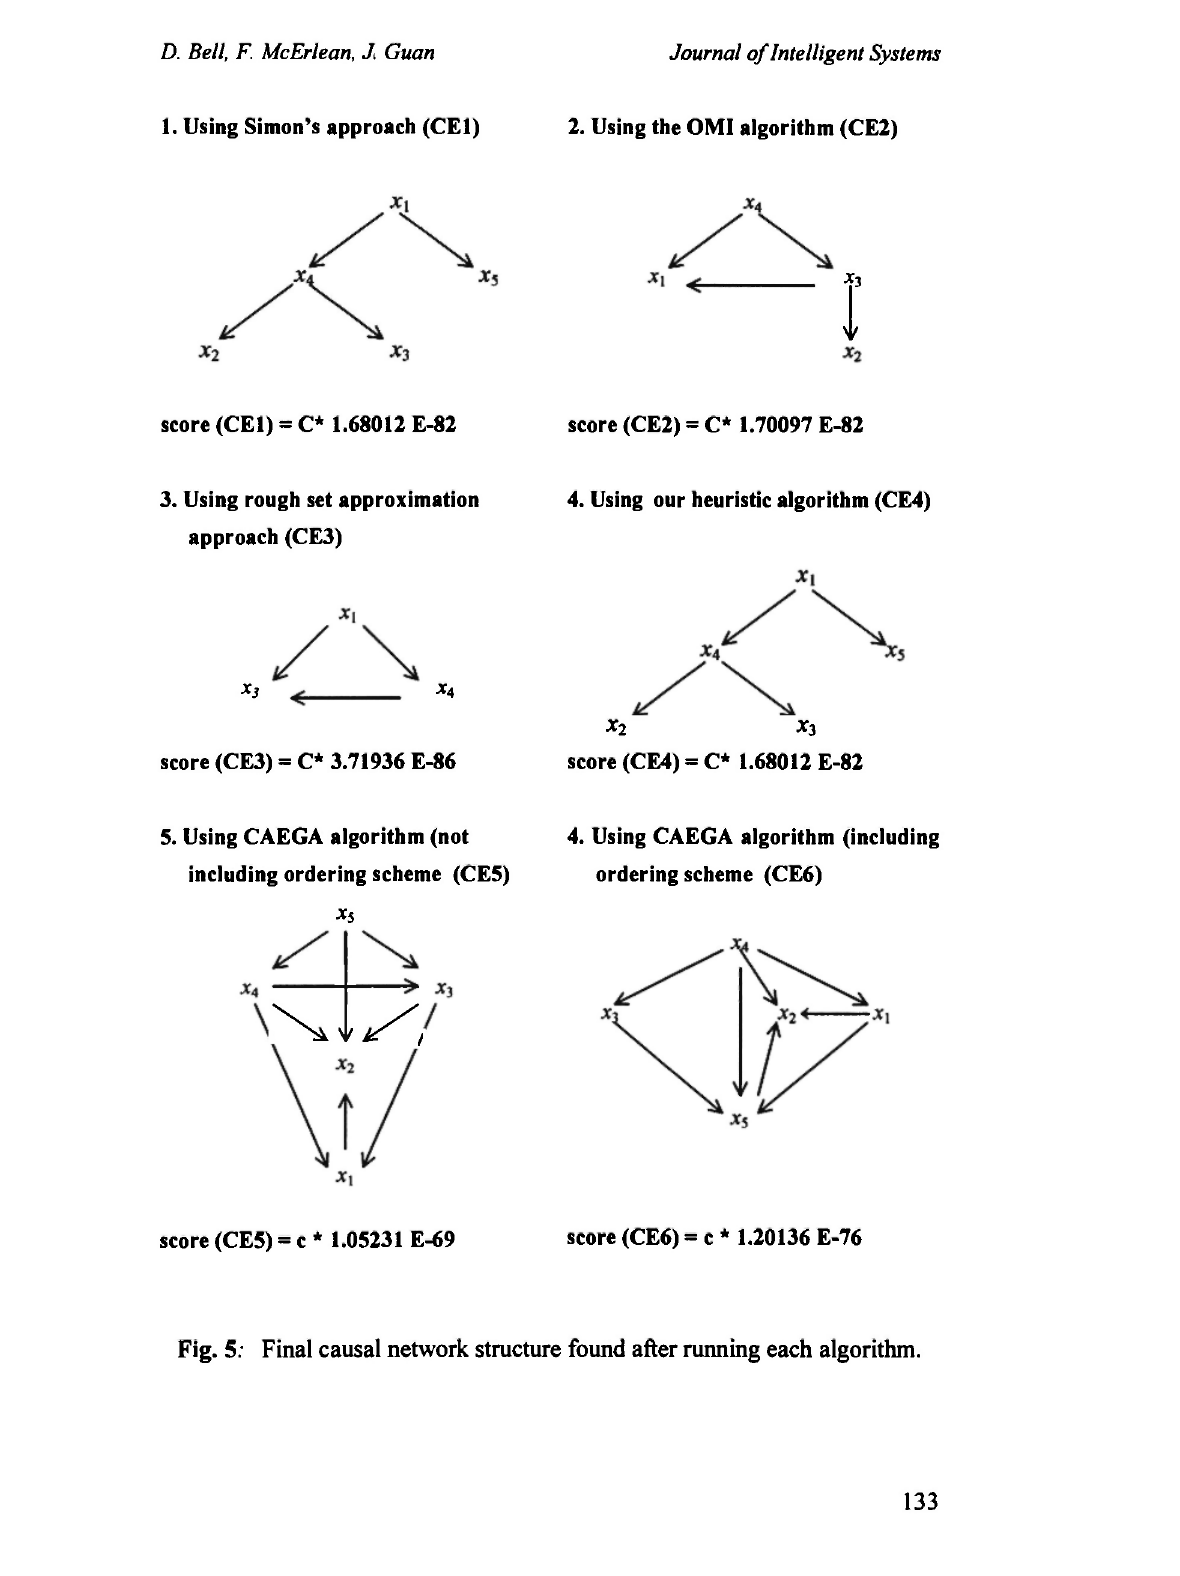
Fig. 5: Final causal network structure found after running each